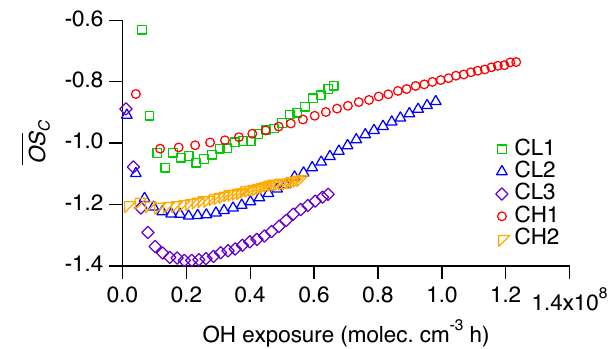
Fig. 5. SOA average carbon oxidation state as a function of OH exposure for high- and low-NO x cyclododecane